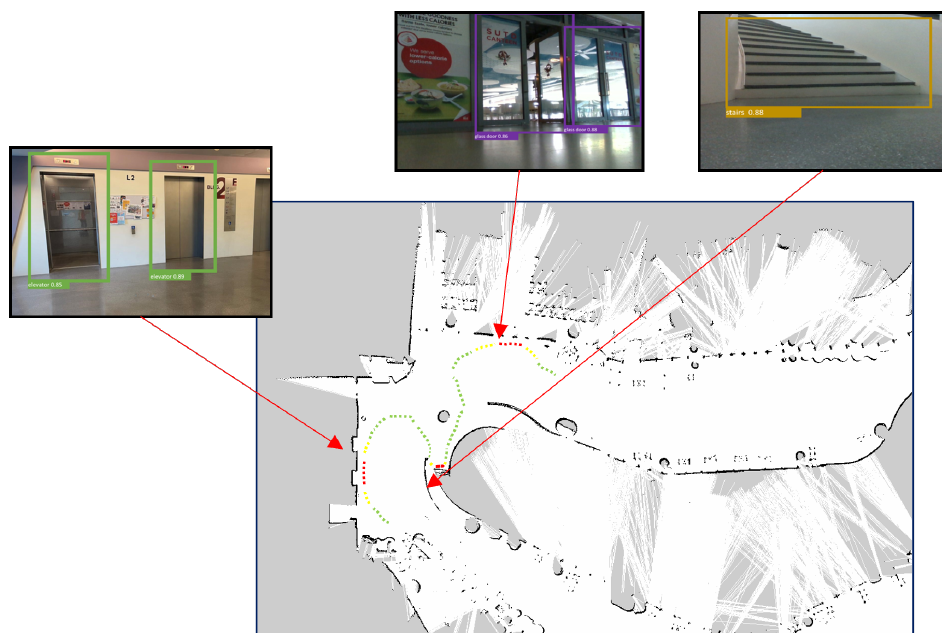
Figure 7. Environment: SUTD